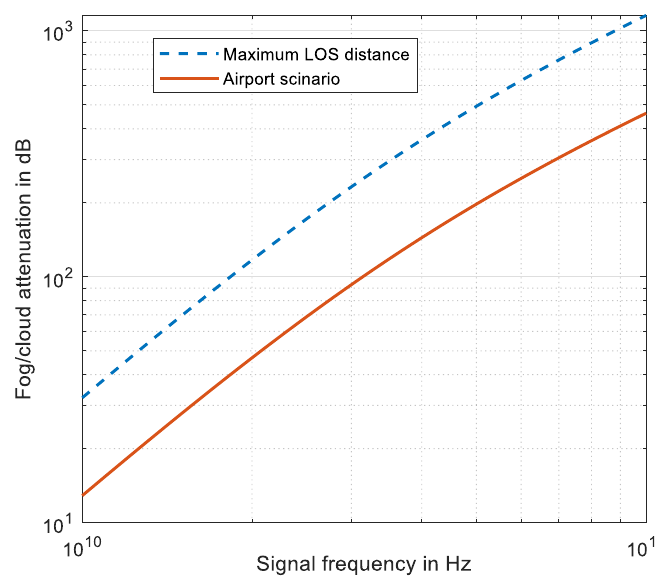
/ cloud attenuation in dB for two aircraft–SB communication Figure 18. Fog/cloud attenuation in dB for two aircraft – SB communication scenarios. Figure 18. Fog